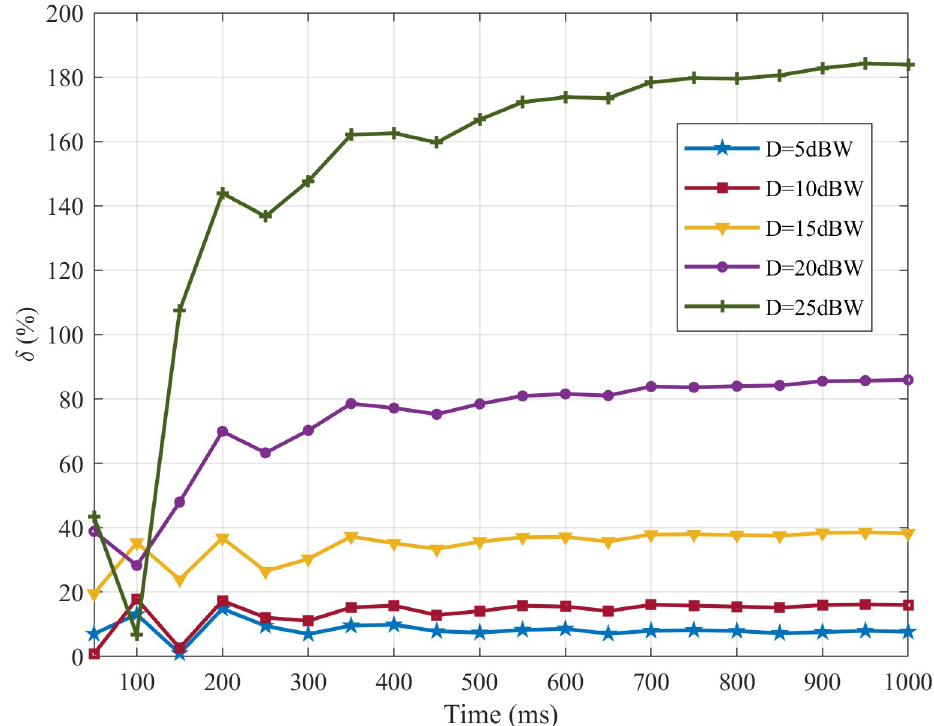
Fig 7. The change in the δ with different noise intensities.